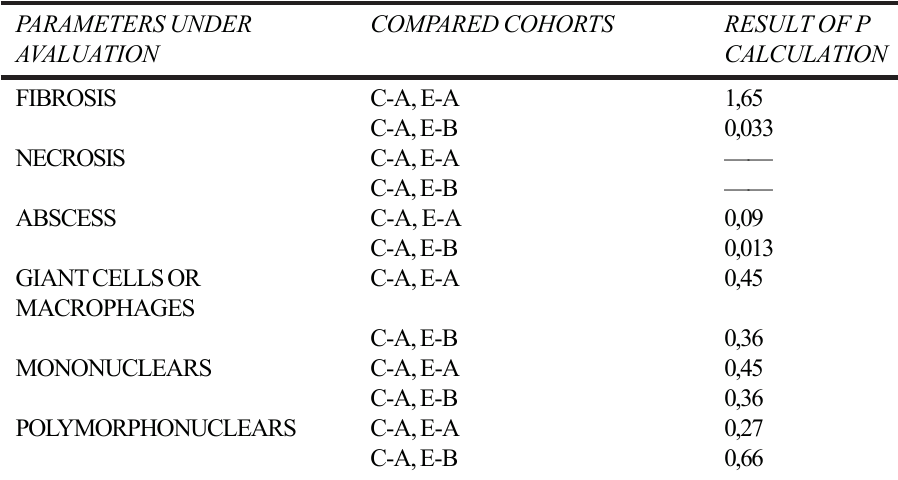
TABLE 6 - Results of the P calculation (comparing the diverse parameters that were analyzed after surgical repair of incisional hernia on abdominal wall of rats) through ANOVA statistic test, showing statistic significance and fixing at 0,05 the